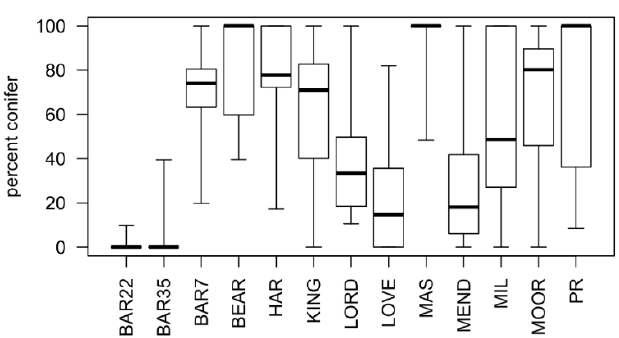
Figure 10. Percentage of conifer forest in the study area.